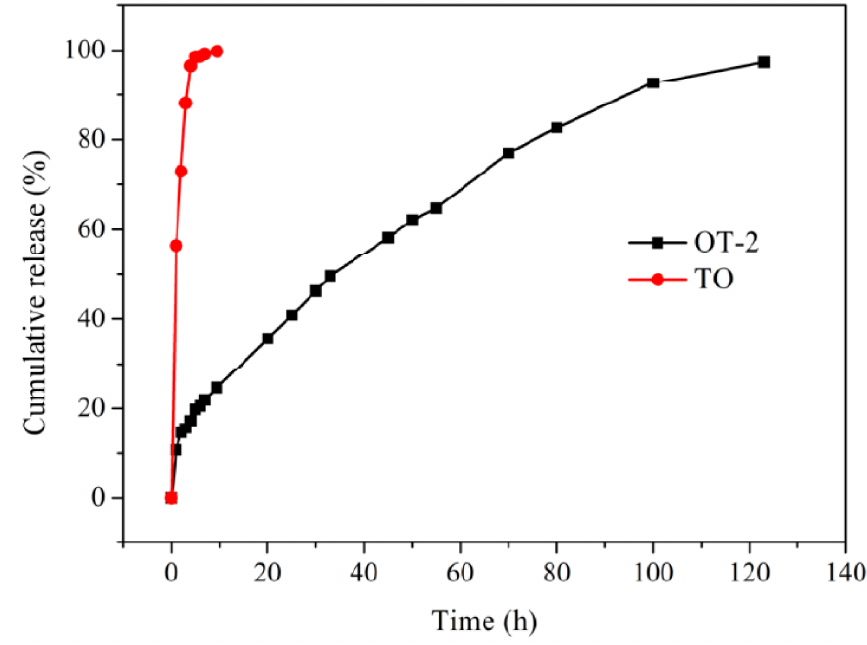
Figure 10. Release curves of TO and composite microcapsules (sample OT-2) at 50 ◦